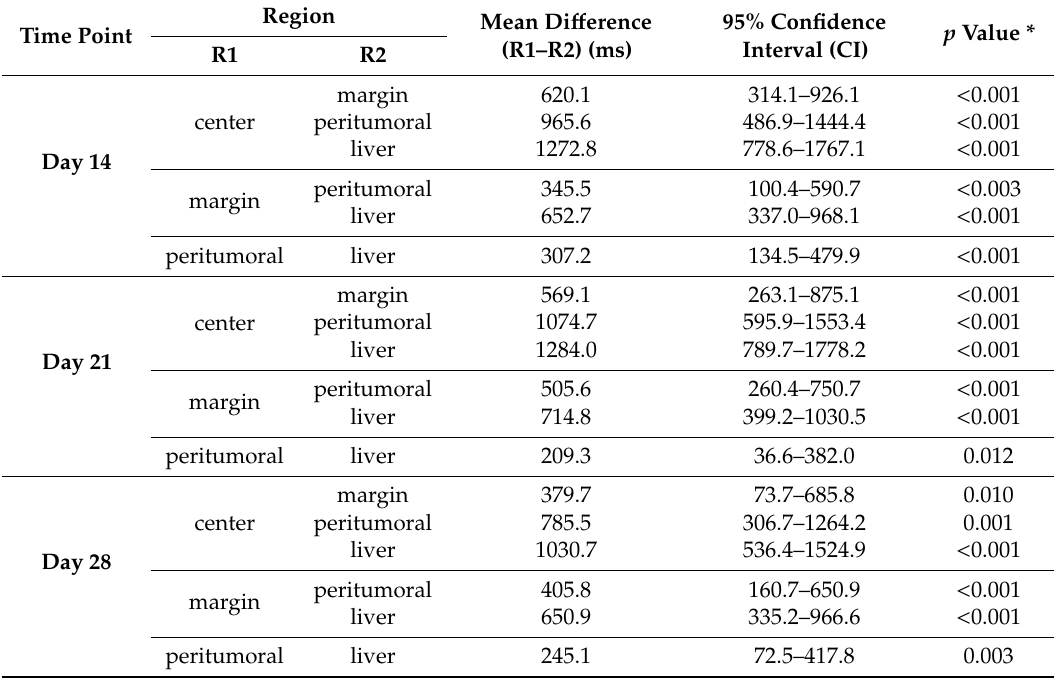
Figure 4. Association of T1 mapping and collagen staining in all animals. ( A ) Mean with standard deviation error bar of T1 times in different tumor areas 14, 21, and 28 days following tumor implantation; ( B ) mean with standard deviation error bar of the percentage collagen area stain (%) (Picrosirius red stain) at the three time points. Table 1. Discriminatory power of T1 times (ms) between the tumor (center, margin) and peritumoral regions averaged for all time points.